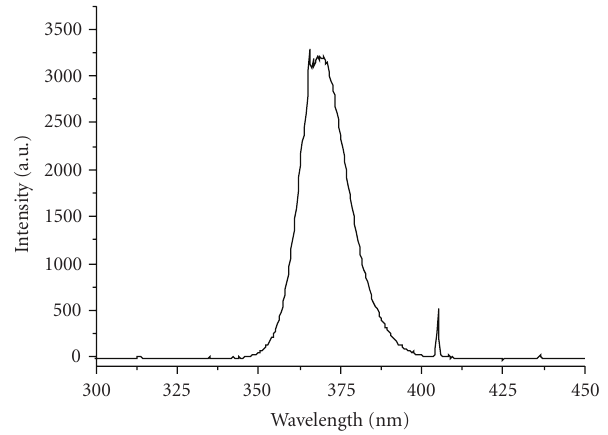
Figure 1: Emission spectrum of UV